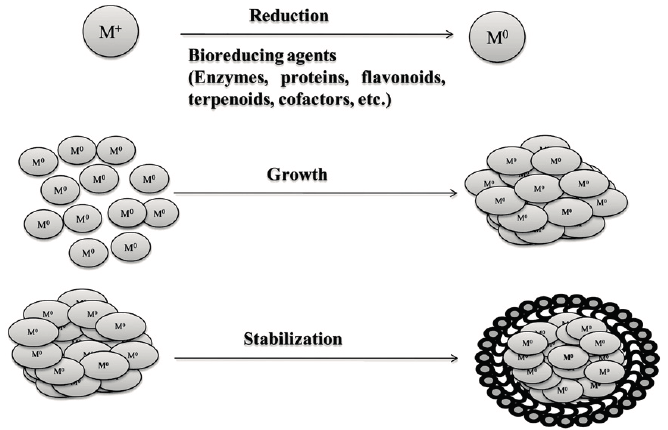
Figure 1. The formation of the metal nanoparticles (Me-NPs) during biosynthesis. Reprint from [12] with permission from Elsevier, copyright 2013. M + , metal ion; M 0 , reduced metal